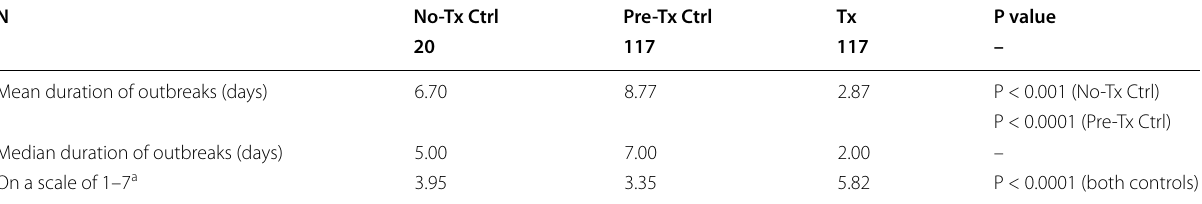
Tx treatment a Where 1 is “very long time” and 7 is “didn’t have symptoms”